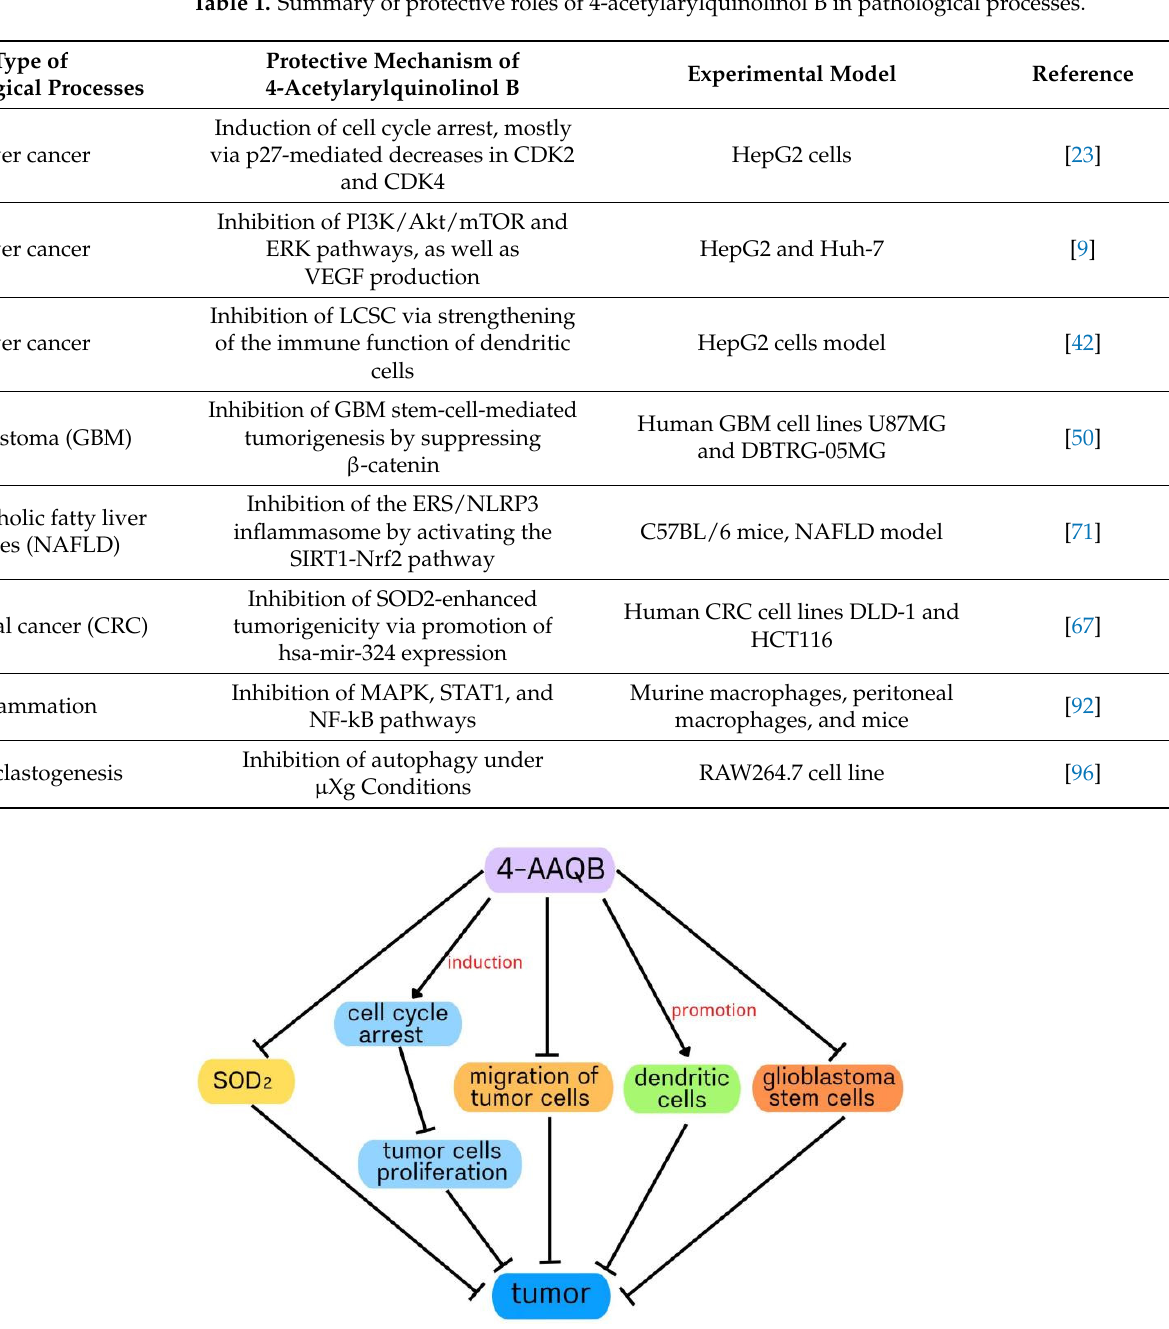
Figure 3. Schematic diagram of the antitumor mechanism of 4-AAQB.